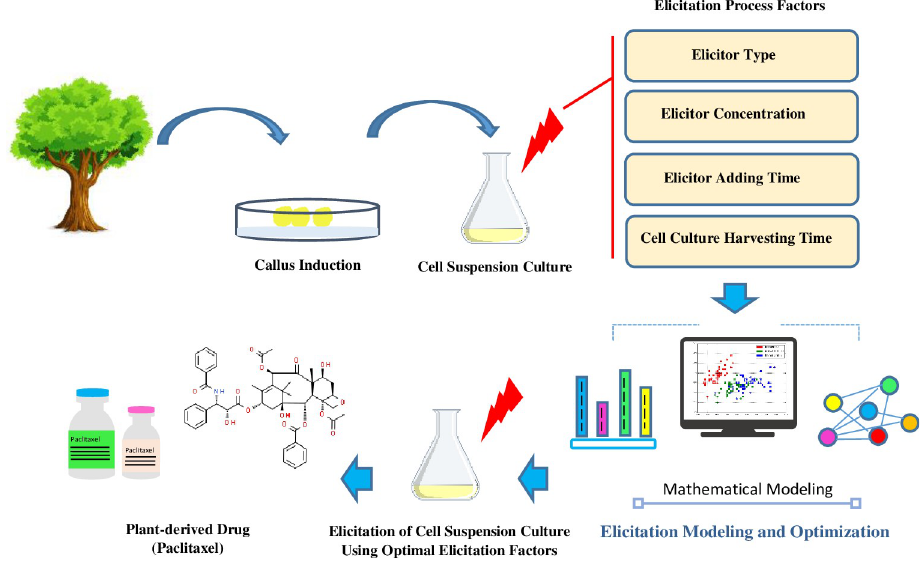
Fig 2. Graphical abstract of the